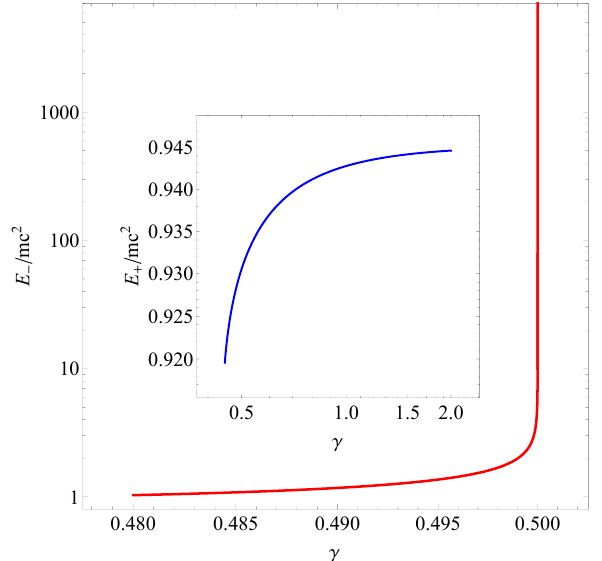
Figure 2. The total energy of particle at the ISCO position as functions of the γ parameter. Table 1. The orbital velocity and energy of test particles orbiting at the ISCO position around the central objects described by the Schwarzschild, extreme Reissner-Nordström RN and γ -metric. Spacetime − g tt